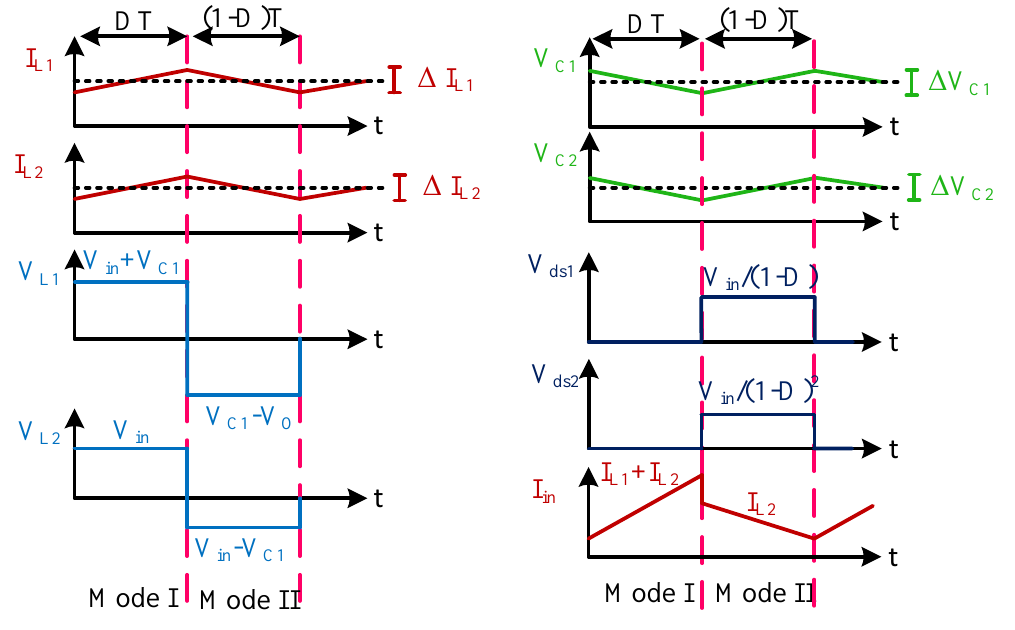
Figure 4. Related waveforms in CCM.